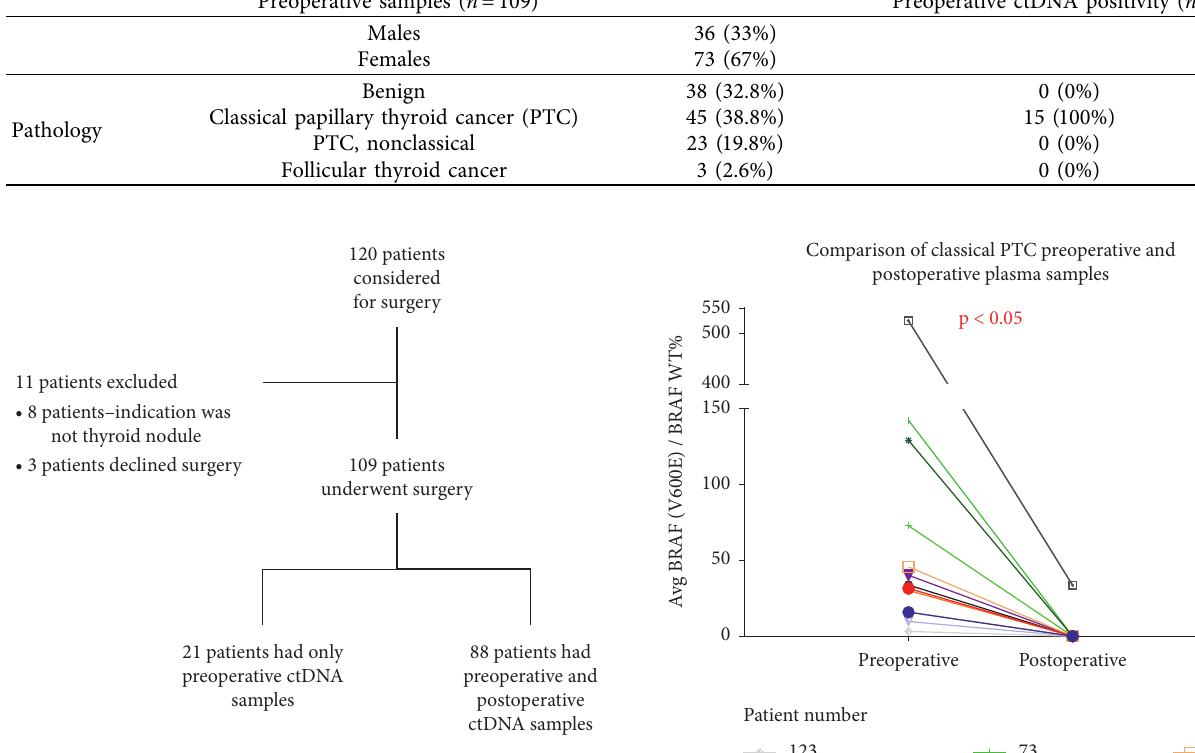
Figure 1: Patient recruitment—inclusion and exclusion.